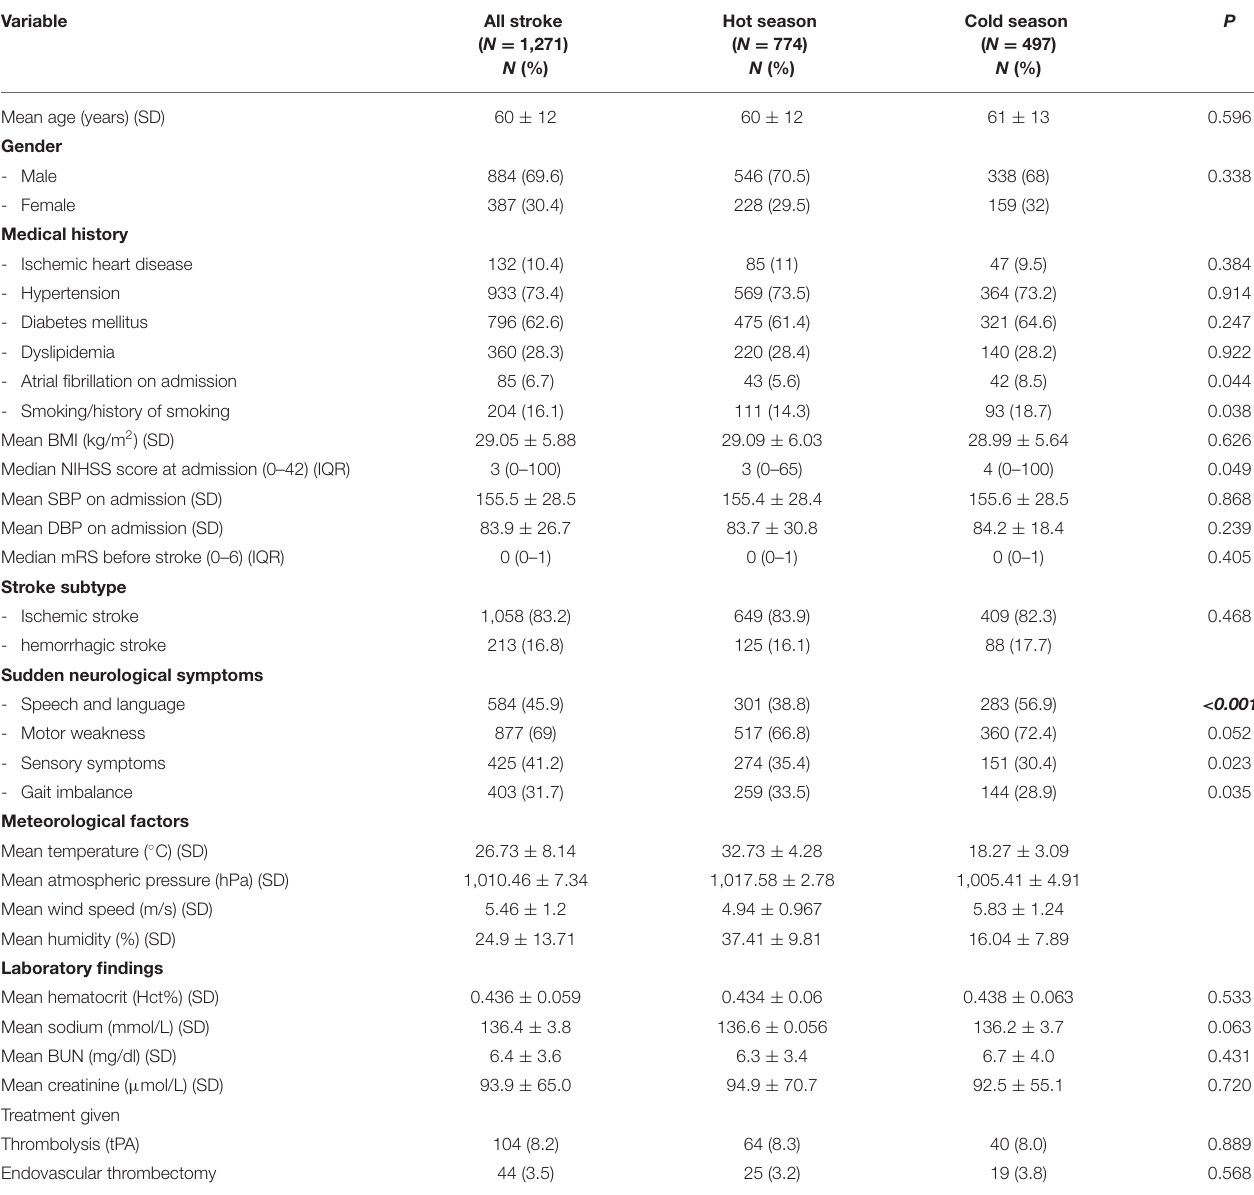
TABLE 1 | The demographic and clinical characteristics of patients with ischemic and hemorrhagic stroke in hot and cold seasons.